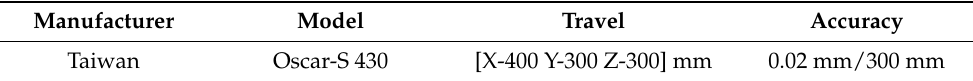
Table 4. EDM set-up